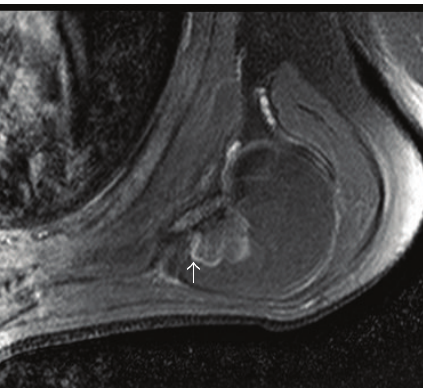
Figure 5: T1 fat saturated postcontrast axial image showing enhancement of interface between the bony protuberance and the lipid component of the lesion suggesting the fibrous tissue rim (white